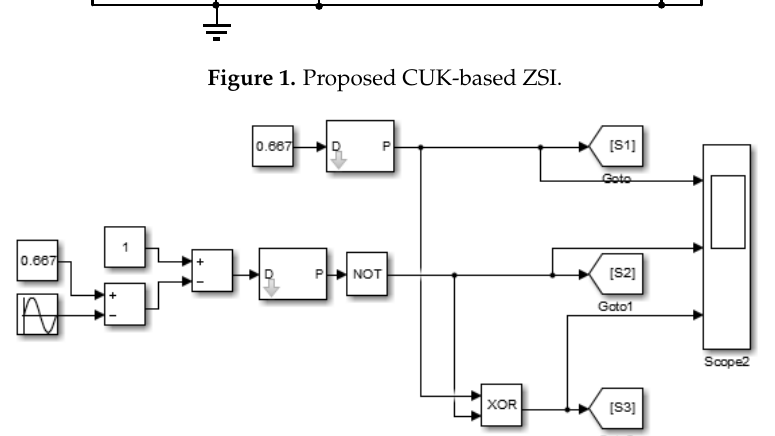
Figure 1. Proposed CUK-based ZSI.